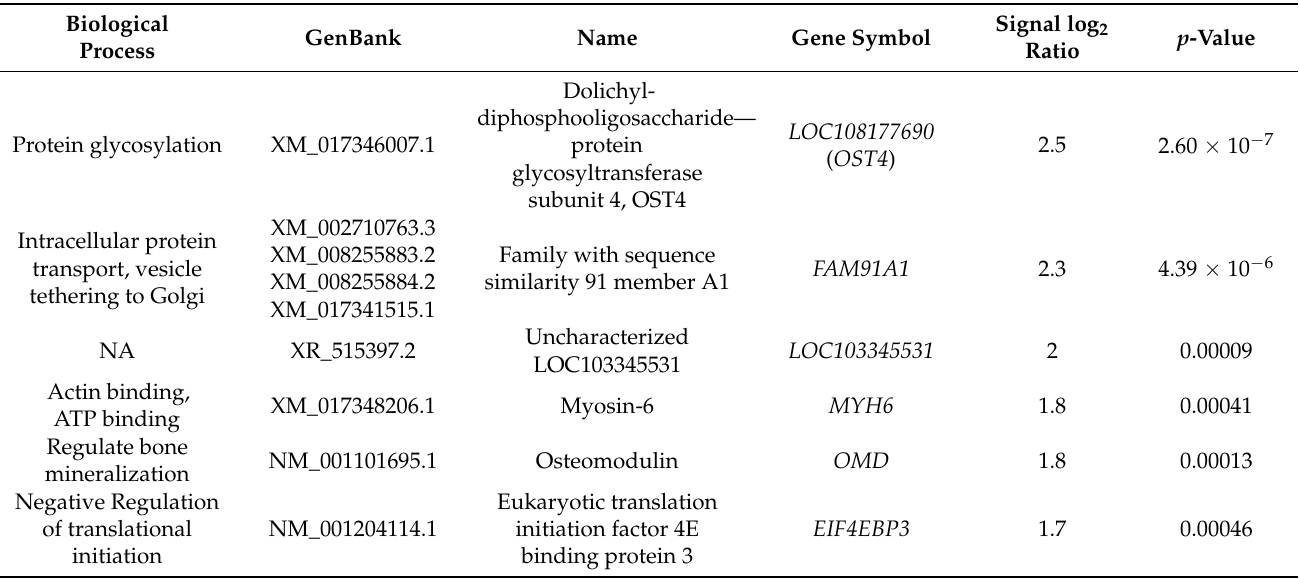
Table 2. Hepatic transcripts differentially upregulated by the administration of squalene at the level of signal log 2 ratio > 1.5 and false discovery rate < 0.001 in male Oryctolagus cuniculus according to